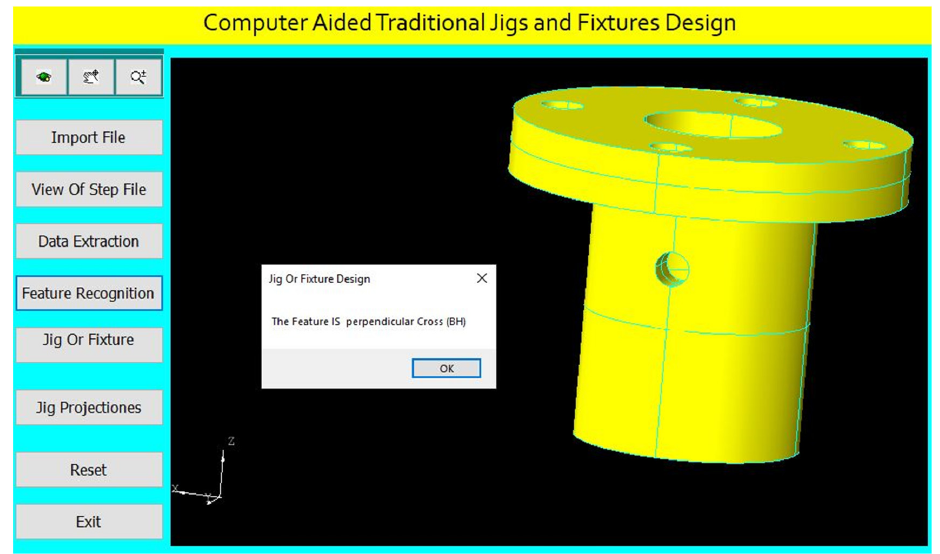
Figure 21. Automatic feature recognition of a perpendicular cross blind hole. For drilling the perpendicular cross blind hole of (4 mm) diameter, the program checks the inner boring of (16 mm) diameter for identifying the appropriate locator diameter. identifying the suitable guide bush.